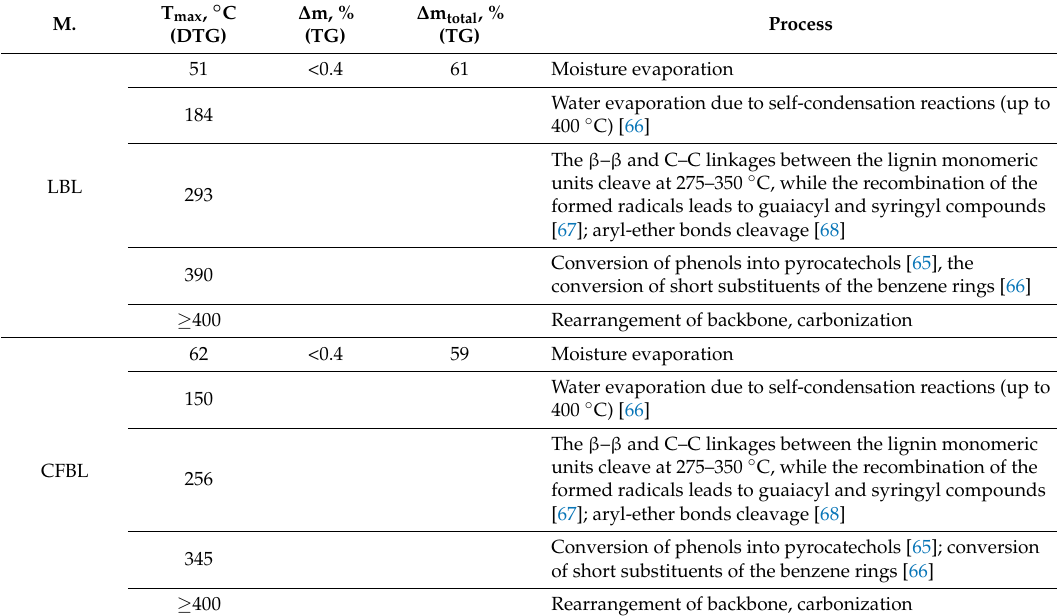
Table 3. Characteristics of thermal decomposition in the N 2 atmosphere of studied materials. M.